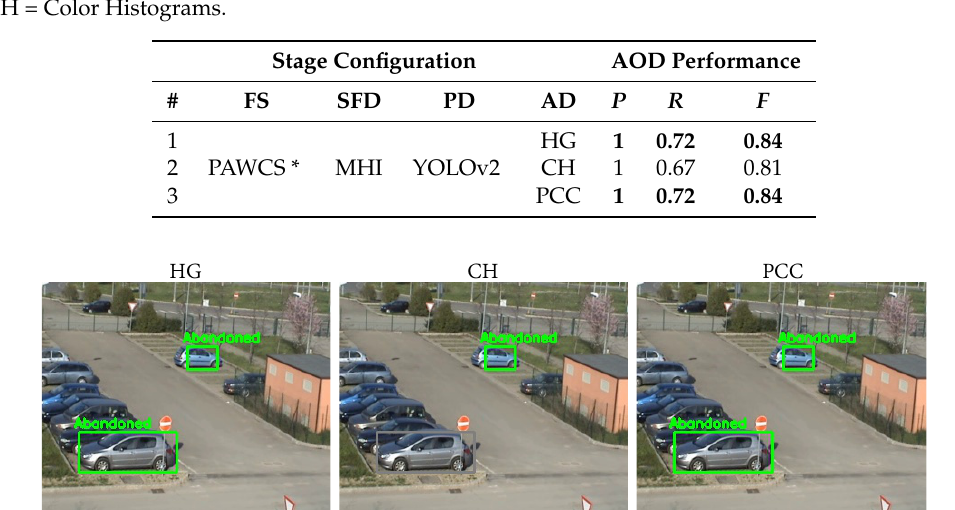
Figure 14. From left to right are shown the abandoned discrimination obtained with the HG, CH, and PCC algorithms for the same frame of the VISOR 00 sequence. HG and PCC correctly detected both cars as abandoned, while CH missed one of the detections (marked in grey) due to the wrong